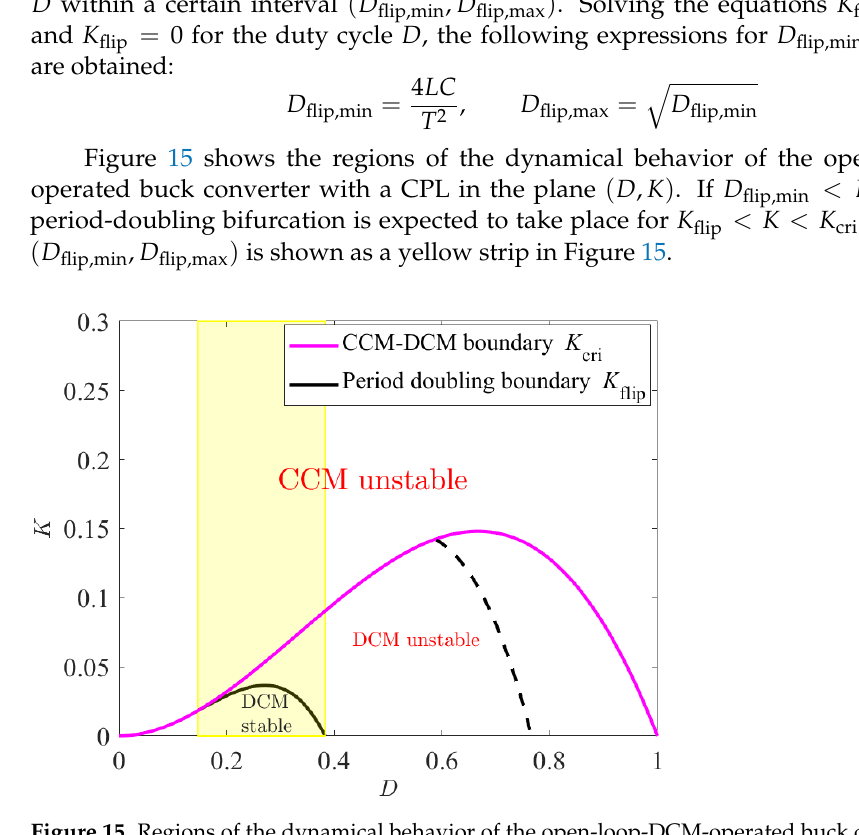
Figure 15. Regions of the dynamical behavior of the open-loop-DCM-operated buck converter with a CPL in the plane ( D , K )